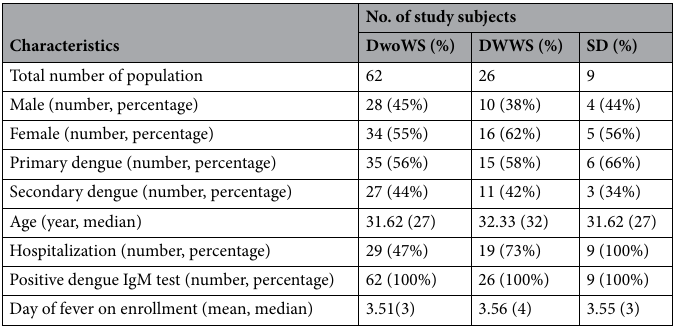
Table 1. Demography of study